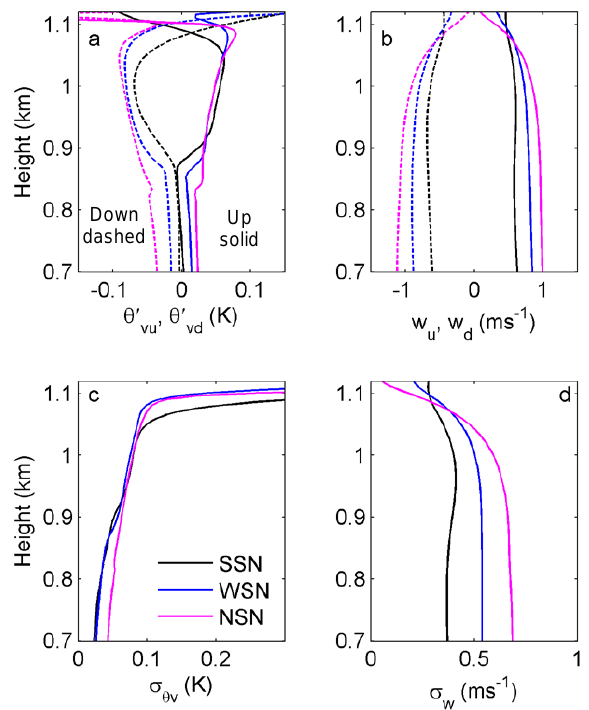
Fig. 11. Updraft-downdraft variables of convective circulation for three no-solar simulations. (a) Averaged perturbations of buoyancy; (b) averaged updraft/downdraft velocity; (c) σ θ v ; and (d) σ w . Dashed lines are for downdraft variables, solid updraft variables.